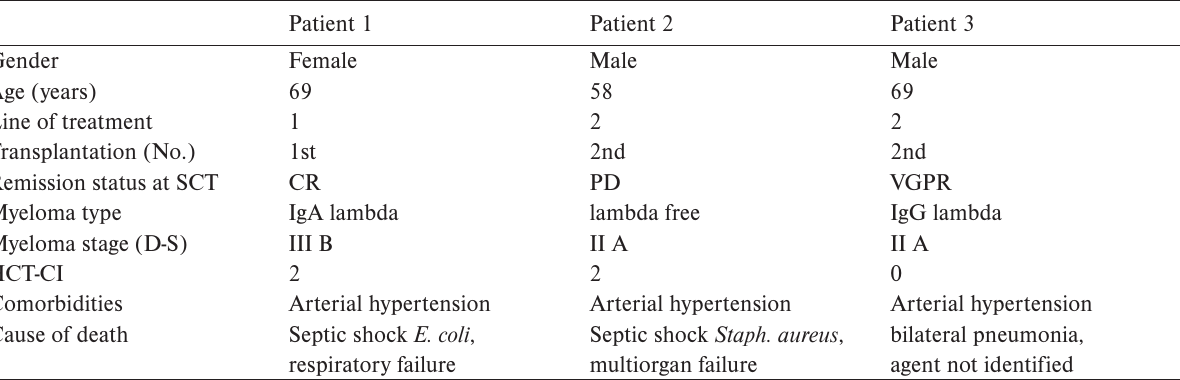
Table 4. Characteristics of patients with fatal